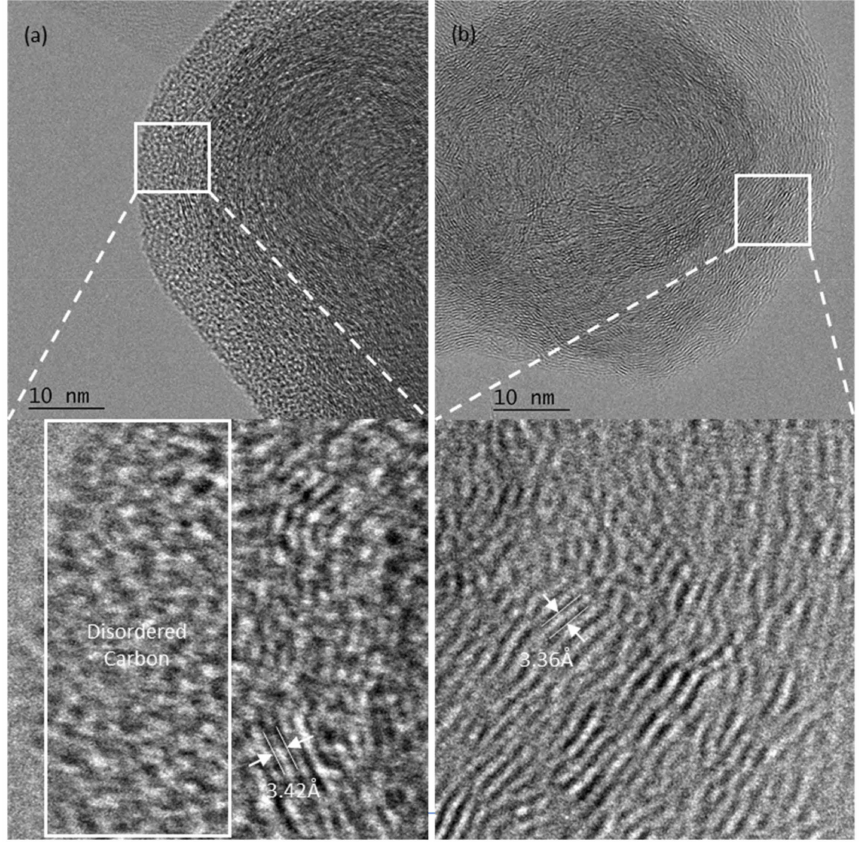
Figure 2. TEMimagesofcarbonpowder( a )pre-annealingand( b )post-annealingat400,000 × magnification. The I-V characteristics of the carbon powder samples were taken pre- and post- annealing to be compared. The I-V characteristics were tested using a four-point probe station, and the average of the results with error margins for the samples pre-annealing are shown in Figure